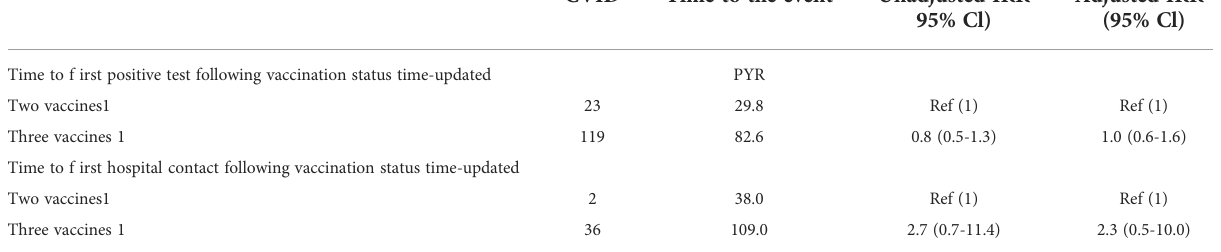
TABLE 3 Vaccine